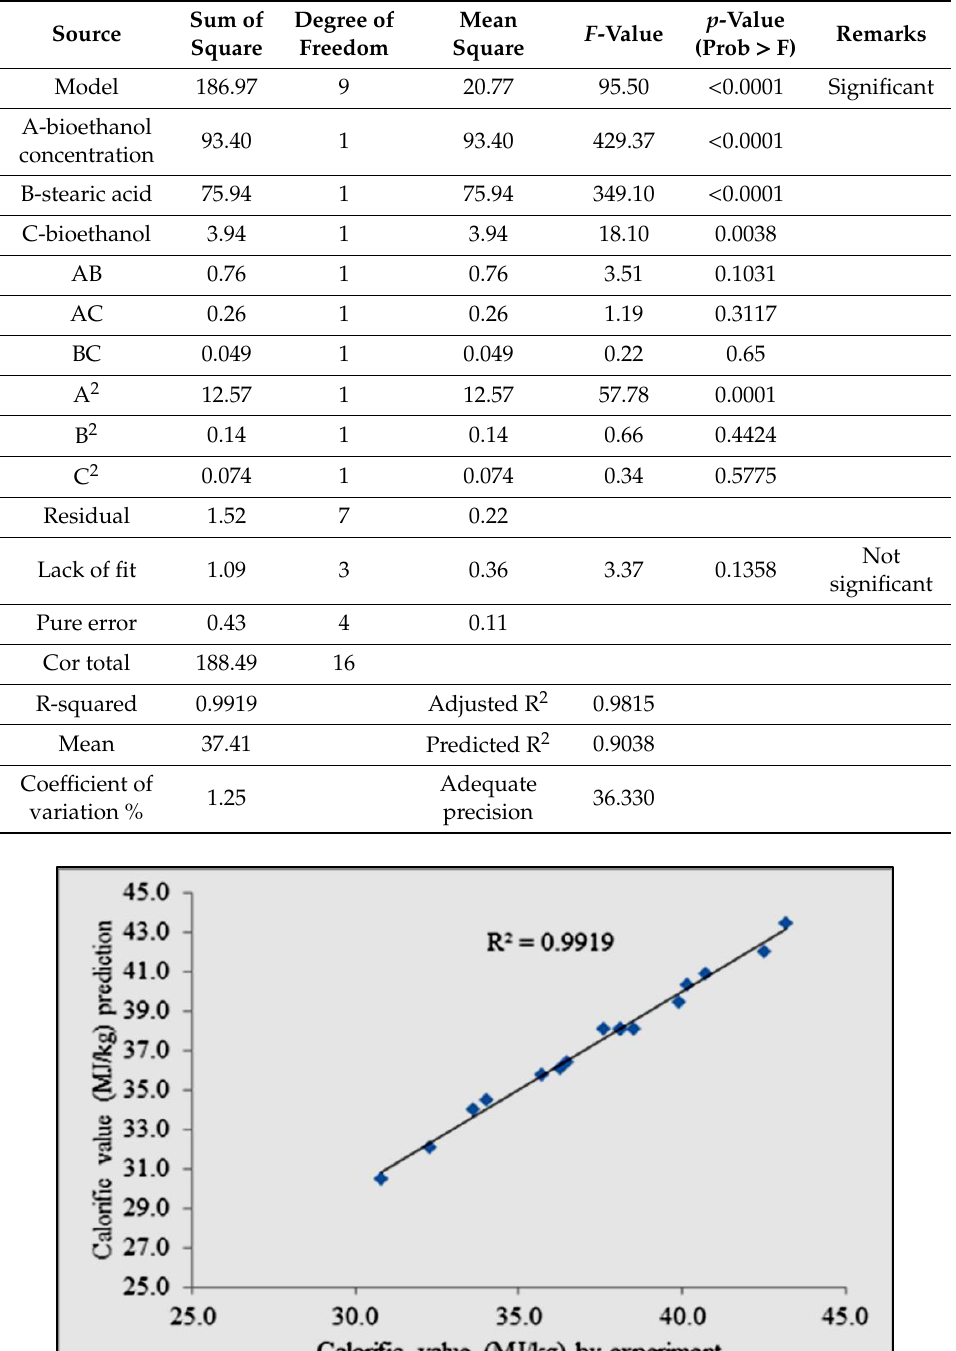
Table 3. Analysis of variance by ANOVA.